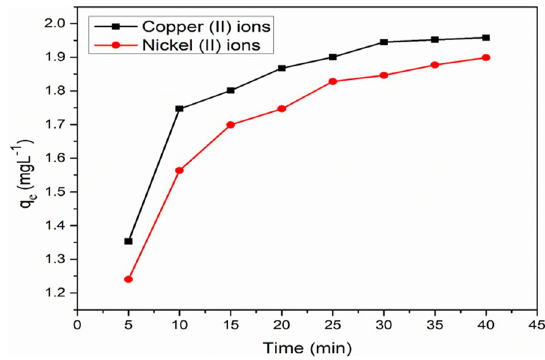
Figure 11. Combination of Cu 2+ and Ni 2+ ions in solution with 20 mg L −1 at T = 30